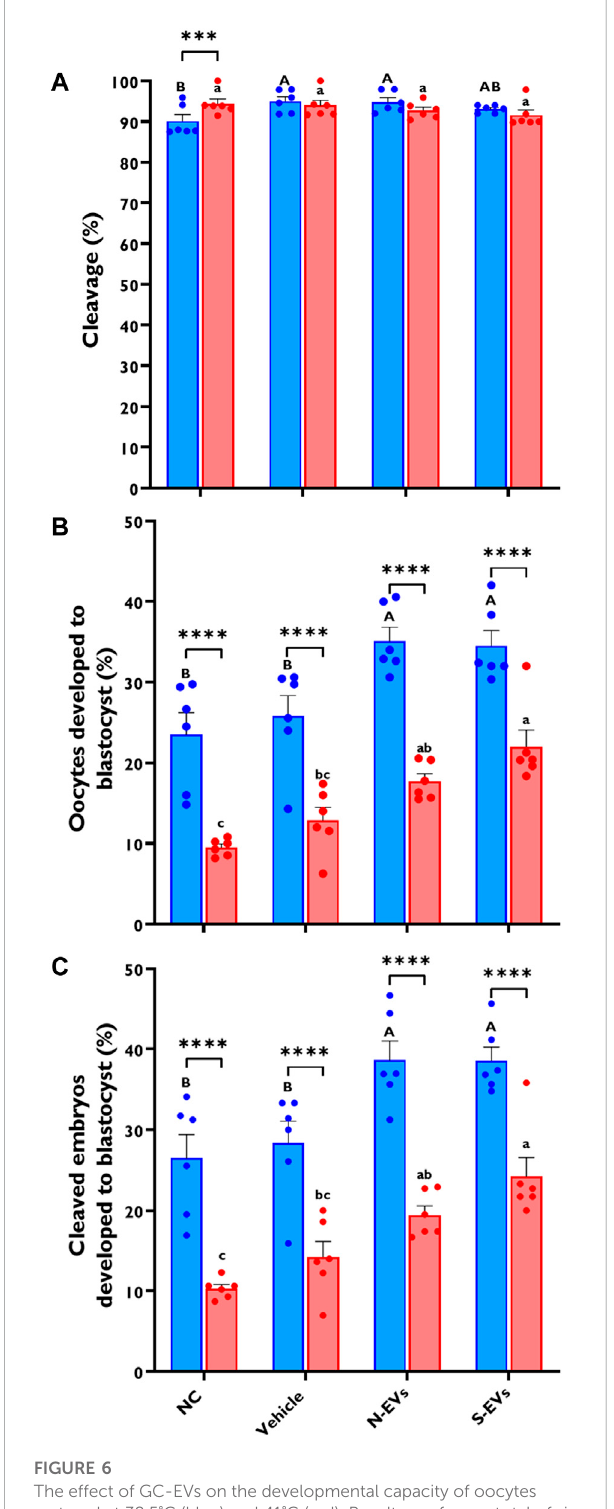
FIGURE 6 The effect of GC-EVs on the developmental capacity of oocytes matured at 38.5 ° C (blue) and 41 ° C (red). Results are from a total of six replicates (281 – 299 total oocytes per treatment). Oocytes supplemented with N-EVs and cultured under 38.5 ° C showed signi fi cant improvements in cleavage percentage compared to the NC, while no visual differences were observed among treatments under HS conditions (A) . The percentage of oocytes developed into blastocysts was signi fi cantly affected by maturation temperature with signi fi cant increases in developmental competence in